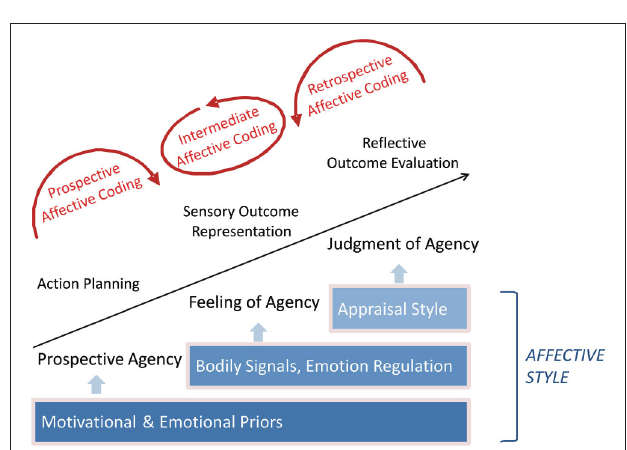
FIGURE 2 | Illustration of the influence of distinct emotional determinants at different stages of agency processing . At the first stage of action planning, priors derived from affective state, affective trait or affective context variables influence prospective representations of agency (prospective affective coding). At the second stage, feelings of agency can be shaped by rapid appraisal of emotionally salient information and emotional bodily responses (intermediated affective coding). Thirdly, positive or negative self-schemas and self-enhancement or self-protection motives may guide post-hoc explicit attributions of agency (retrospective affective coding). Finally, individual differences in the degree of emotion regulation during an affective state (affective style) may moderate the interplay between emotion and agency at all three levels of